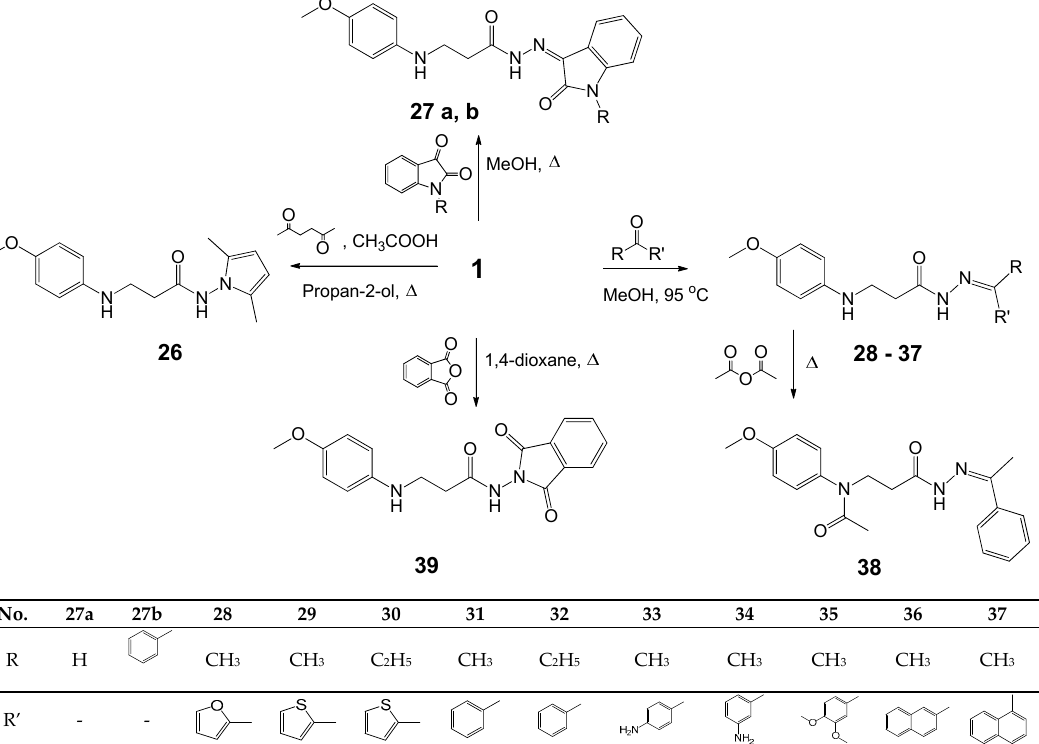
Table 1. DPPH scavenging activity of compounds 1 – 39 .